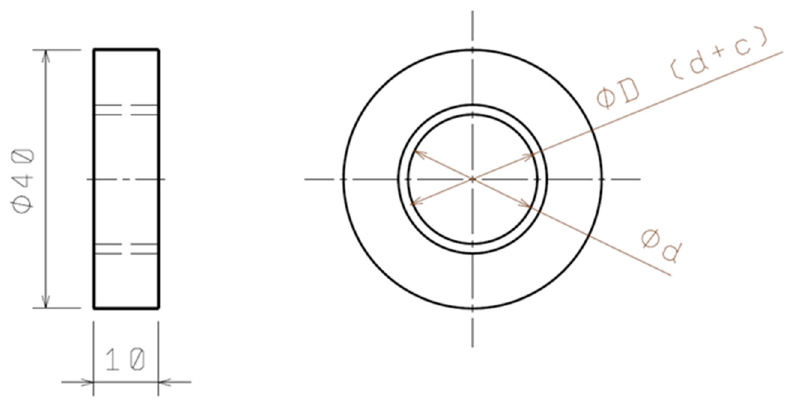
Figure 1. The test sample.